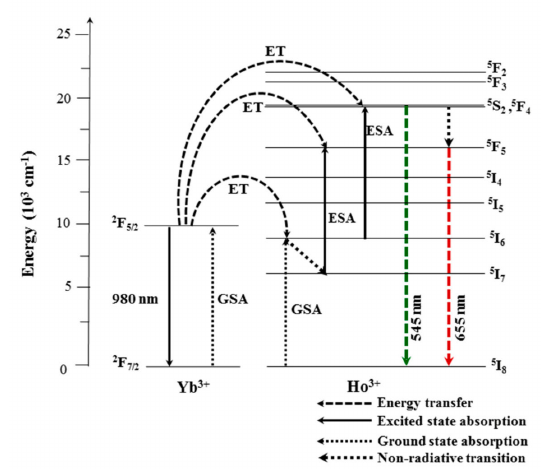
Figure 5. The upconversion (UC) output emission spectra of ( a ) AgGd 0.6 Ho 0.05 Yb 0.35 (MoO 4 ) 2 , ( b ) AgGd 0.55 Ho 0.05 Yb 0.40 (MoO 4 ) 2 , ( c ) AgGd 0.50 Ho 0.05 Yb 0.45 (MoO 4 ) 2 , and ( d ) AgGd 0.45 Ho 0.05 Yb 0.50 (MoO 4 ) 2 excited by 980 nm at room temperature.